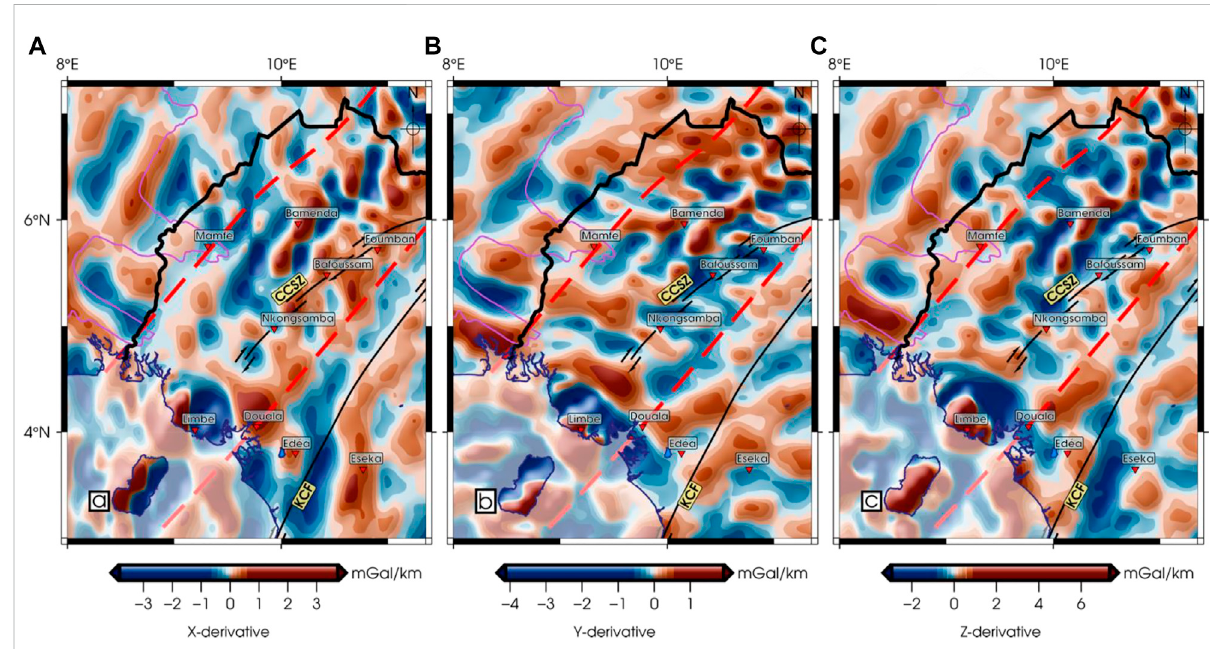
FIGURE 6 First-orderderivativeoftheBouguerresidualanomalymap: (A) inthe X -direction; (B) in Y -direction;and (C) in Z -direction(blacklinesrepresent national